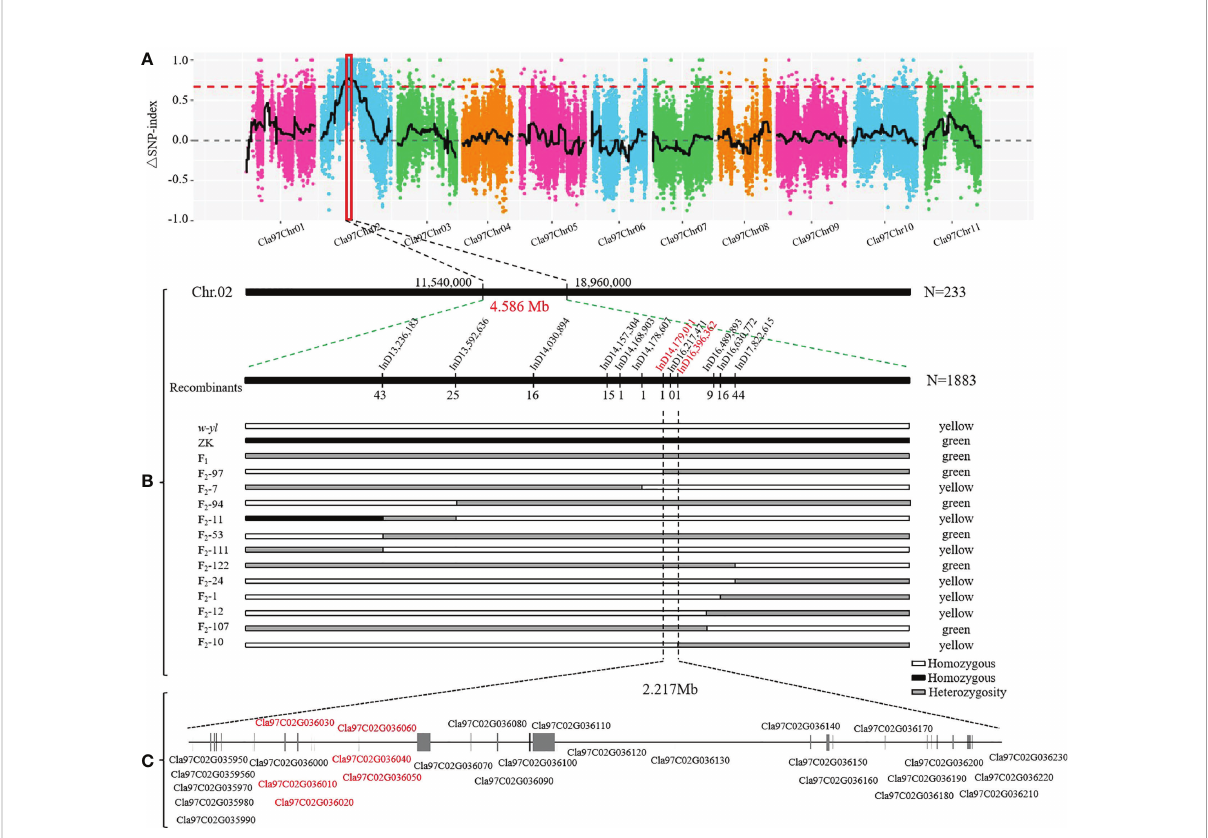
FIGURE 6 Location of yellowing gene on watermelon chromosome 2. (A) D (SNP-index) of watermelon chromosomes. (B) The candidate genes was mapped to a 4.586 Mb region between InD14,179,011 and InD16,396,362 on chromosome 2. (C) Putative genes in the candidate region based on the watermelon reference genome